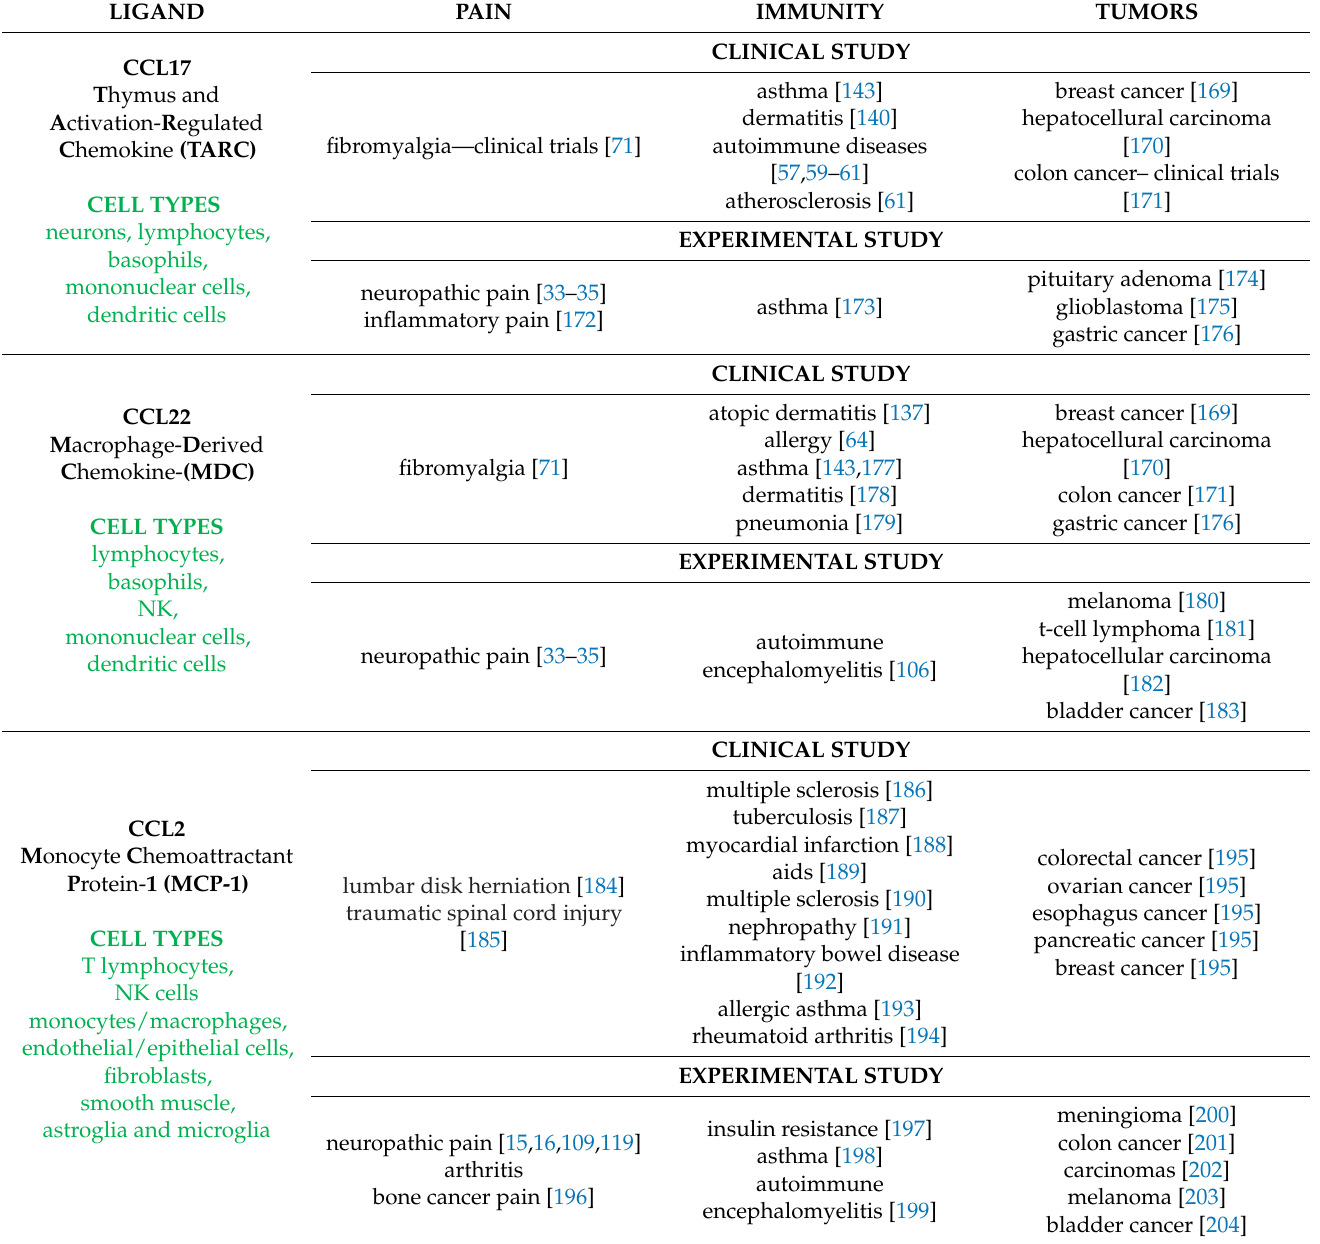
Table 1. Summary of the involvement of CCL2, CCL17, and CCL22 in different health problems in the cases of pain, immunity, and tumor